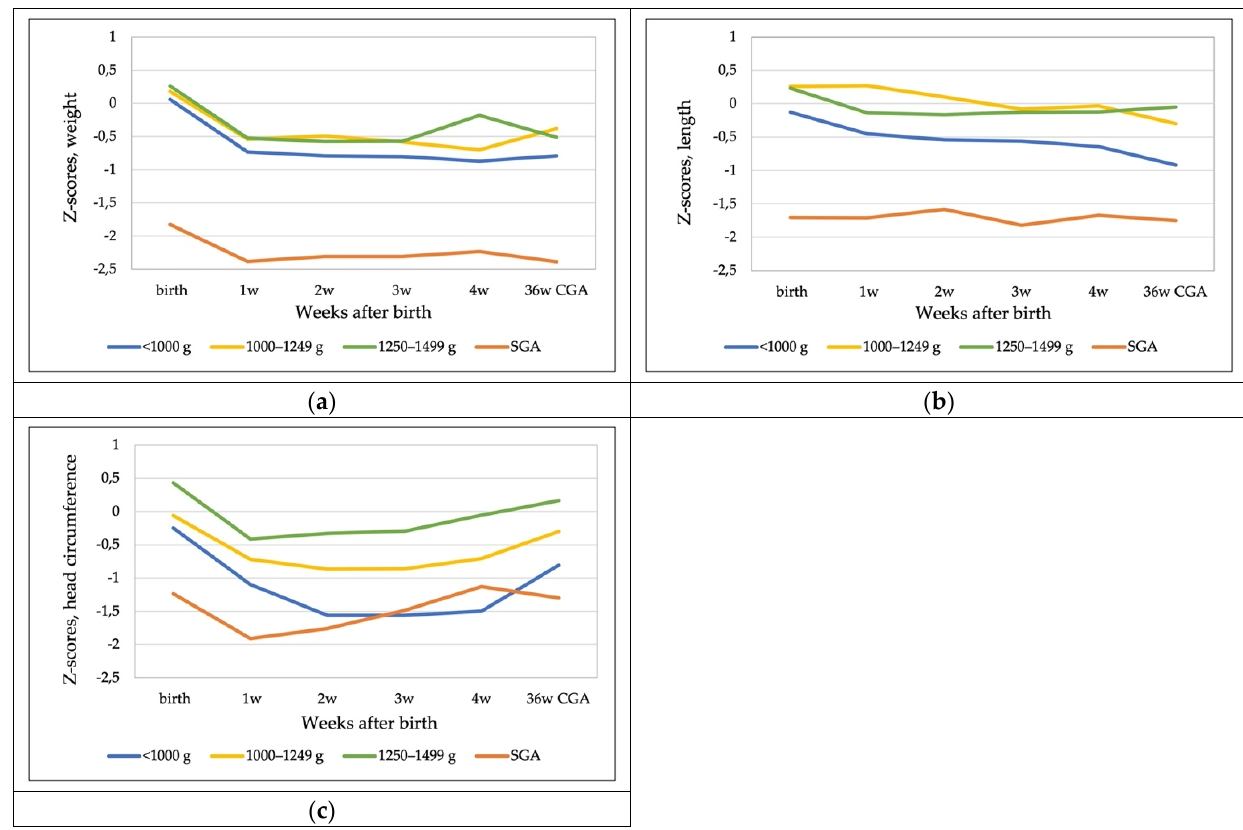
Figure 4. Z-scores for weight, length, and head circumference of infants of different birth weight groups and SGA infants (Fenton reference) from birth to 28 days and 36 weeks CGA or discharge. Table 3. Change in z-scores of weight, length, and head circumference (HC) in different birth weight groups from birth to 28 days and 36 weeks CGA or discharge.